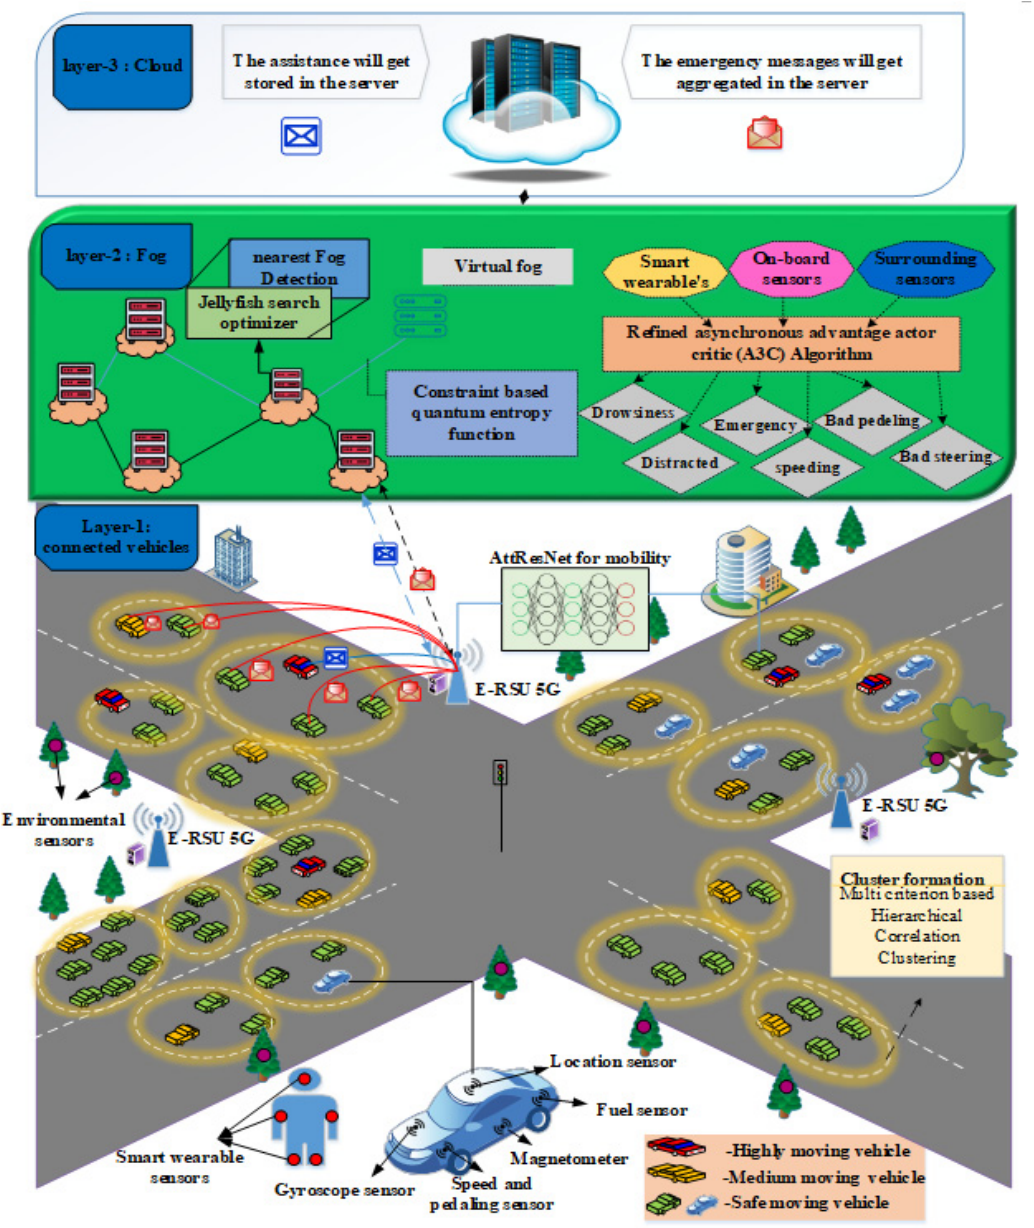
Figure 1. Three Tier Architecture.